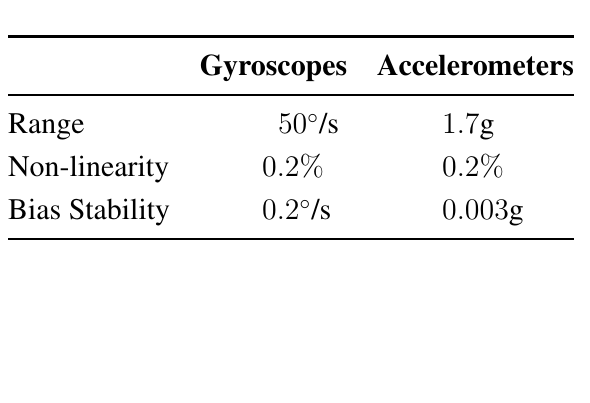
Table 1. Properties of the MEMS based Microstrain 3DM-GX3 35